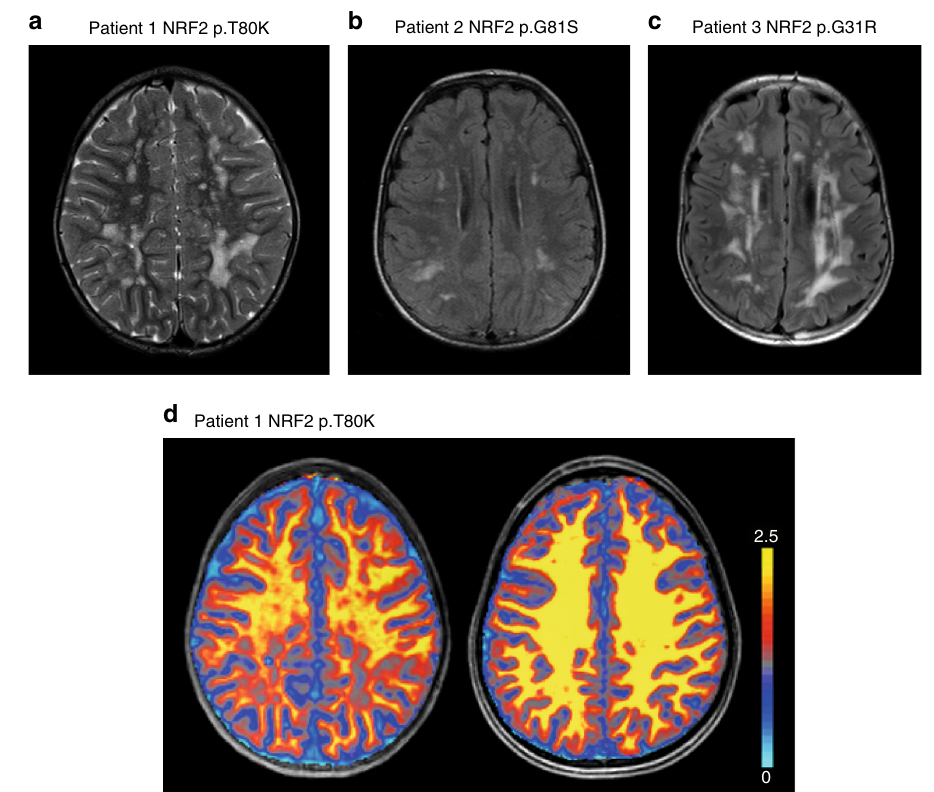
Fig. 1 Activating mutations in NRF2 are associated with supratentorial white matter signal changes on MRI. T2 weighted images ( a , patient 1) or FLAIR ( b , patient 2 and c , patient 3) from three patients showing multiple smaller single or larger con fl uent hyperintense lesions. d Colorcoded MT sat maps overlayed onto the corresponding T1-weighted image of patient 1 (left) and age- and gender-matched healthy control (right). Note the distinct reduction of MT sat within the white matter lesions most pronounced in the occipital regions displaying values close to gray matter. Color scale with the respective MT sat values on the